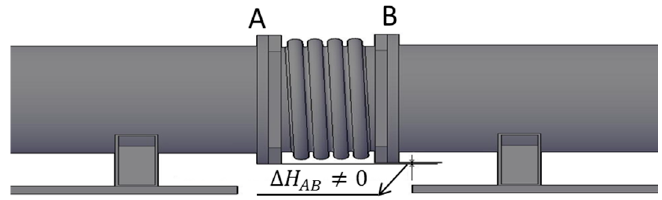
Figure 2. Geometry of GIS shell.